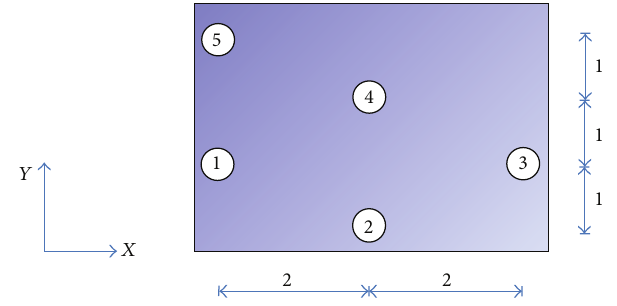
Figure 3: Description of the points to be